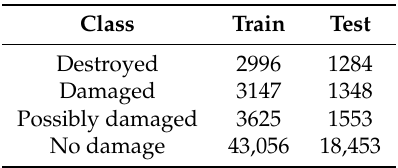
Table 2. Number of train and test